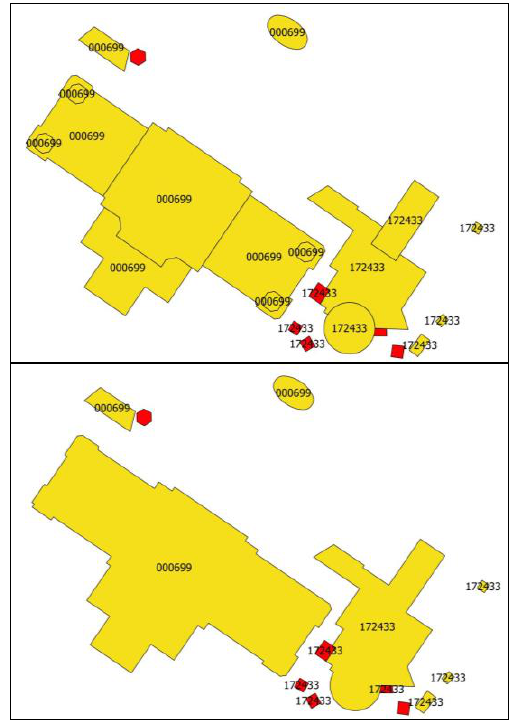
Figure 3. Example of cardinality problems due to the Bezug code: before (top) and after (bottom) dissolve. Even after dissolving common boundaries of the polygons, same codes are shared by several non-adjacent buildings (e.g. 000699, 172433), which cannot be identified uniquely. Features of class 11 and 12 are here represented in yellow, while class 13 is represented in red, as well as their aggregation With respect to the CityGML dataset, a first simple comparative analysis was carried out confronting the Baukörpermodell (from 2015) with a conceptually analogous map (from 2012), obtained by extracting from the CityGML buildings (and building parts) the GroundSurfaces and using them as 2D footprints for reference. From now on and for better readability, these two 2D polygon-based maps will be simply called “Footprints-2015” and “Footprints-2012”, respectively.